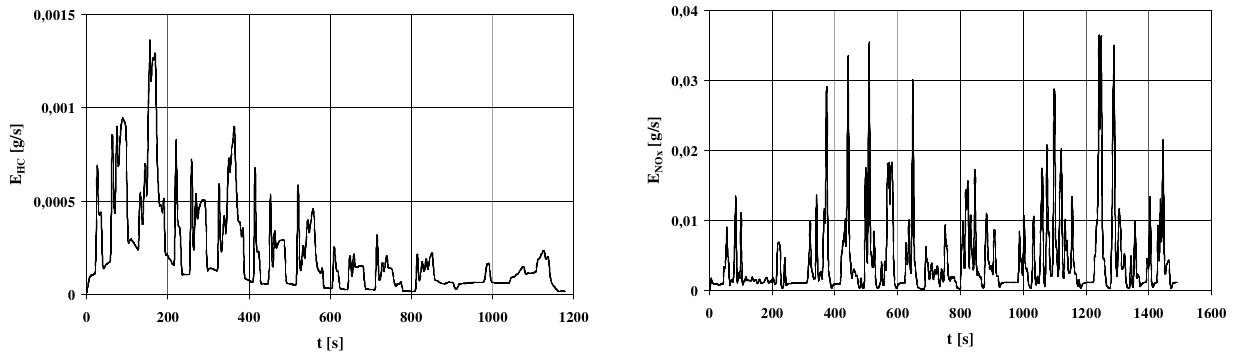
Fig. 10. The emission intensity of hydrocarbons in the NEDC test